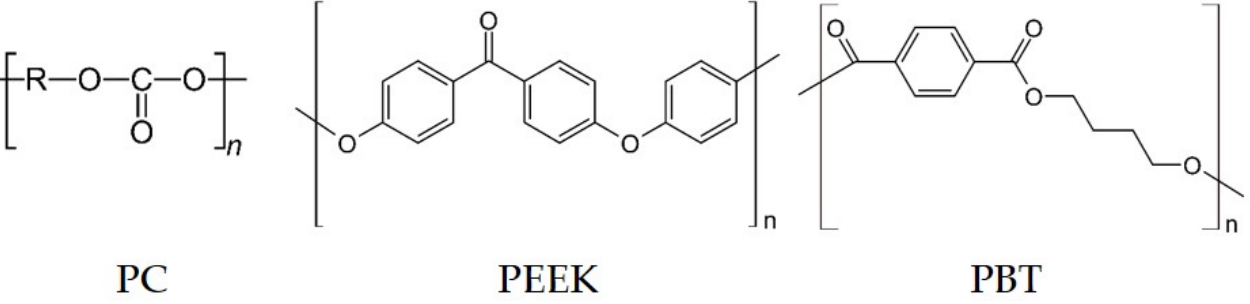
Figure 1. Chemical structure of polymers used in this